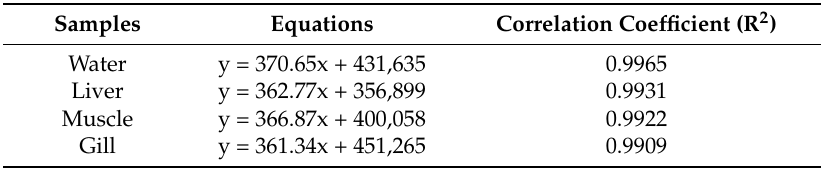
Table 2. Regression equations and correlation coefficients of the standard